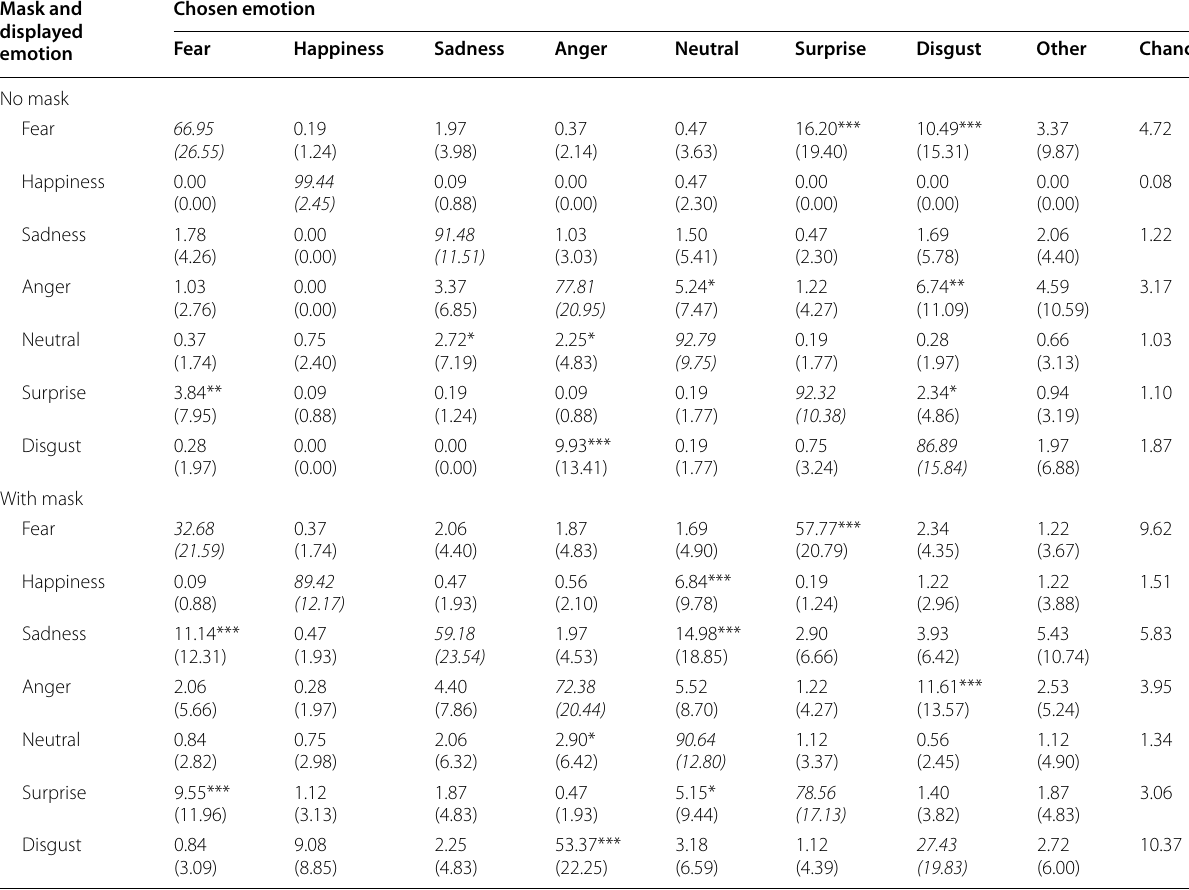
The cells show raw choice percentages instead of the analyzed arcsine transformed percentages. Hit rates are marked in italic. Asterisks indicate confusion percentages above the chance level shown in the right column (* p < .05, ** p < .01, *** p < .001). Chance levels refer to the distribution of confusions only, excluding the hits. Percentages are rounded to two digits and may not add up to exactly 100%